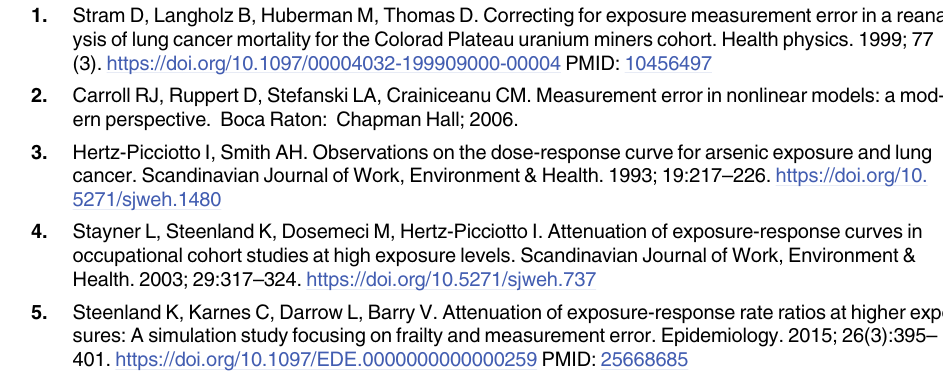
S3 Fig. Estimated exposure-response curve when fitting the Excess Hazard Ratio (EHR) model D based on natural cubic splines when data are generated according to the EHR 3 model D with a risk coefficient of β = 5 assuming additive measurement error. (a) M 1 i.e., no measurement error (b) M , i.e., unshared and homoscedastic Berkson error, (c) M 1 i.e., unshared error of Berkson and classical type (d) M , i.e., heteroscedastic error with a 10 shared classical component describing the imprecision of the measurement device and (e) , i.e., heteroscedastic error with a shared Berkson component describing individual M 11 worker